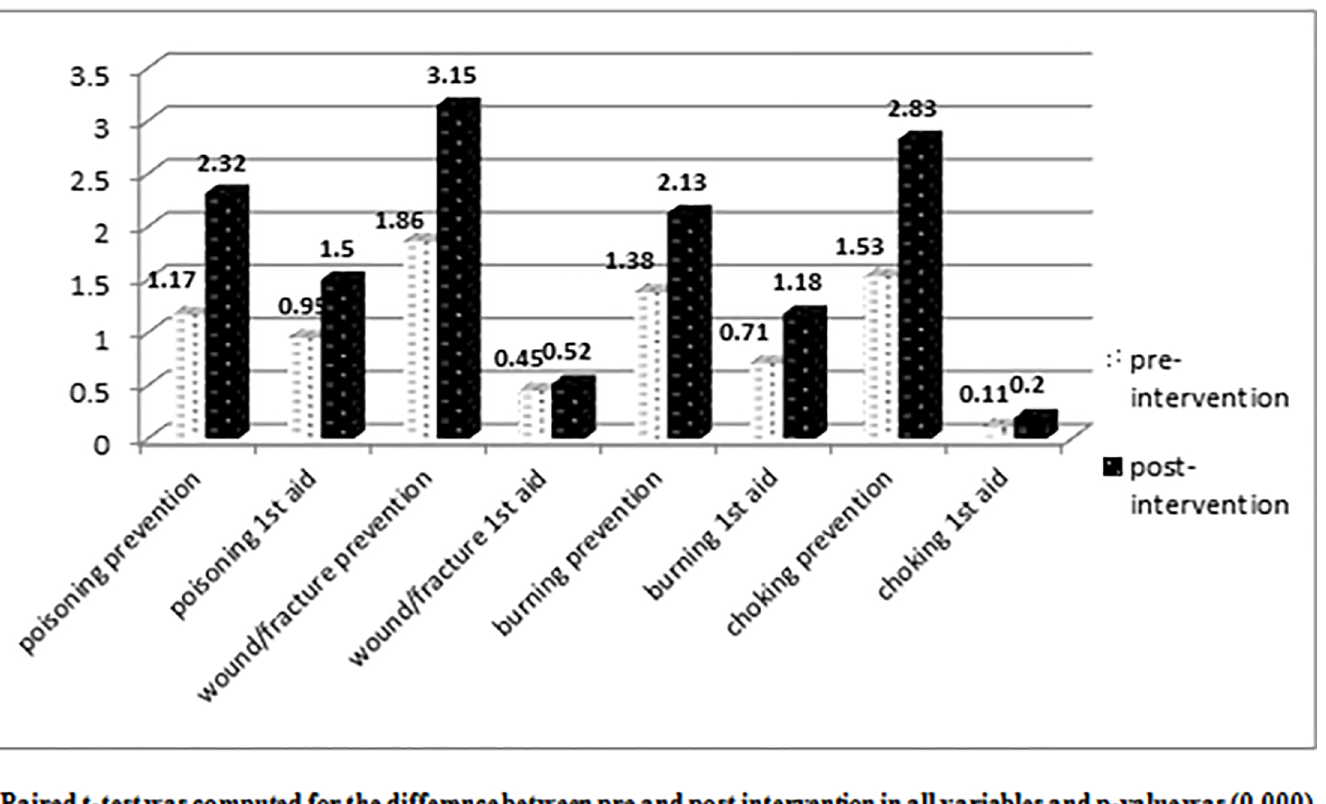
Fig 1. Mean score of knowledge of the participated mothers regarding prevention and first aid measures to the four types of home injuries under study.